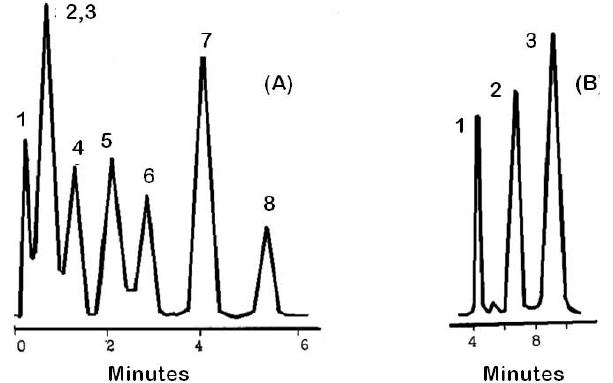
Fig. 2. Chromatograms on (A) GTS-6 for demonstration of high ge- ometrical and chemical uniformity of the surface. The peaks corre- spond to (1) n -hexane, (2) adamantane, (3) n -heptane, (4) n -octane, (5) n -nonane, (6) indene, (7) tetralin, and (8) n -decane. (B) GTS-6 with 0.32% pyrene (sample 1 in Table 1). The peaks correspond to (1) adamantane, (2) endo- and (3)